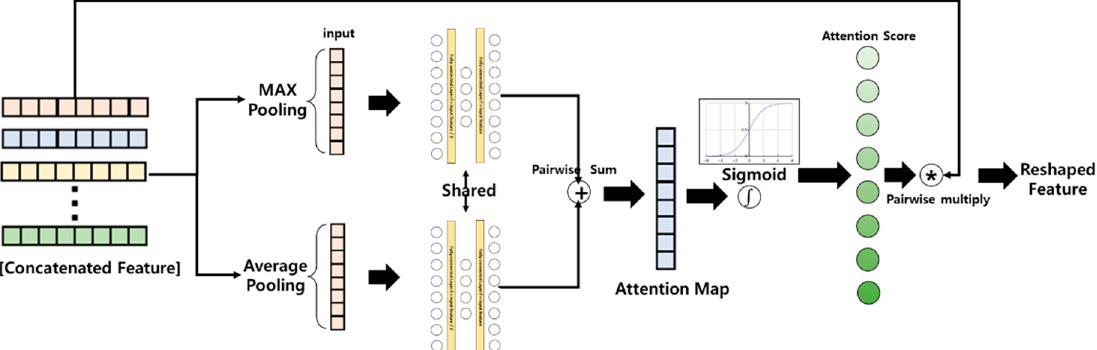
Figure 7. Channel attention layer designed to improve the performance of the model and the importance of each stage of the skeleton data acquired for ADHD screening of children.